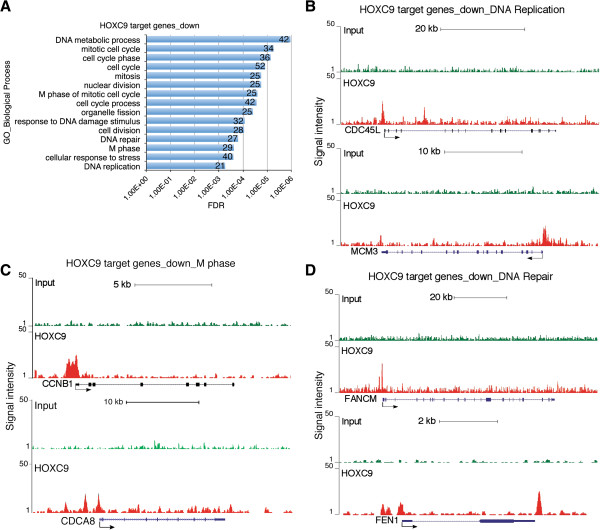
HOXC9 directly represses a large number of cell cycle and DNA repair genes. (A) DAVID analysis of downregulated HOXC9 target genes for enriched GO biological process categories (enrichment fold > 2.0; FDR <1%). The number of genes for each biological process category is indicated. (B-D) ChIP-seq tag profiles showing HOXC9 binding to representative downregulated HOXC9 target genes involved in DNA replication (B), mitosis (C), and DNA repair (D).